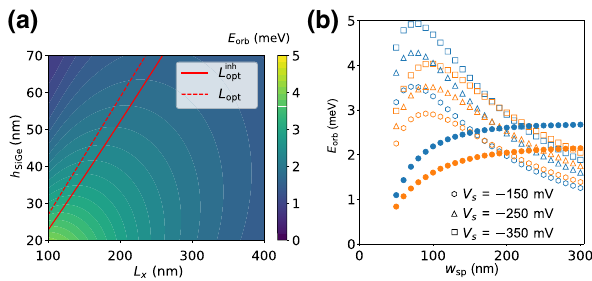
FIG. 6. Orbital splitting as a function of the geometric param- eters of the SQS without disorder. (a) Using h ox = 10 nm and is computed V a = 100 mV, the minimum orbital splitting E x orb by solving the Schrödinger equation on the full-mode periodic potential. The red dashed line indicates L opt and the red solid line the optimal unit-cell length for the case of inhomogeneous (discussed in Appendix A). (b) Orbital splitting dielectics L inh opt (filled symbols) and E y (open symbols) as a function of the E x orb orb gap between the screening gates w sp for an oxide thickness h ox = 5 nm (blue symbols) and h ox = 10 nm (orange symbols) and the voltage V S applied to the screening gates [see the model in Fig. 5(b)]. A fixed sin-signal amplitude V a = 100 mV is applied to the clavier gates and h SiGe = 45